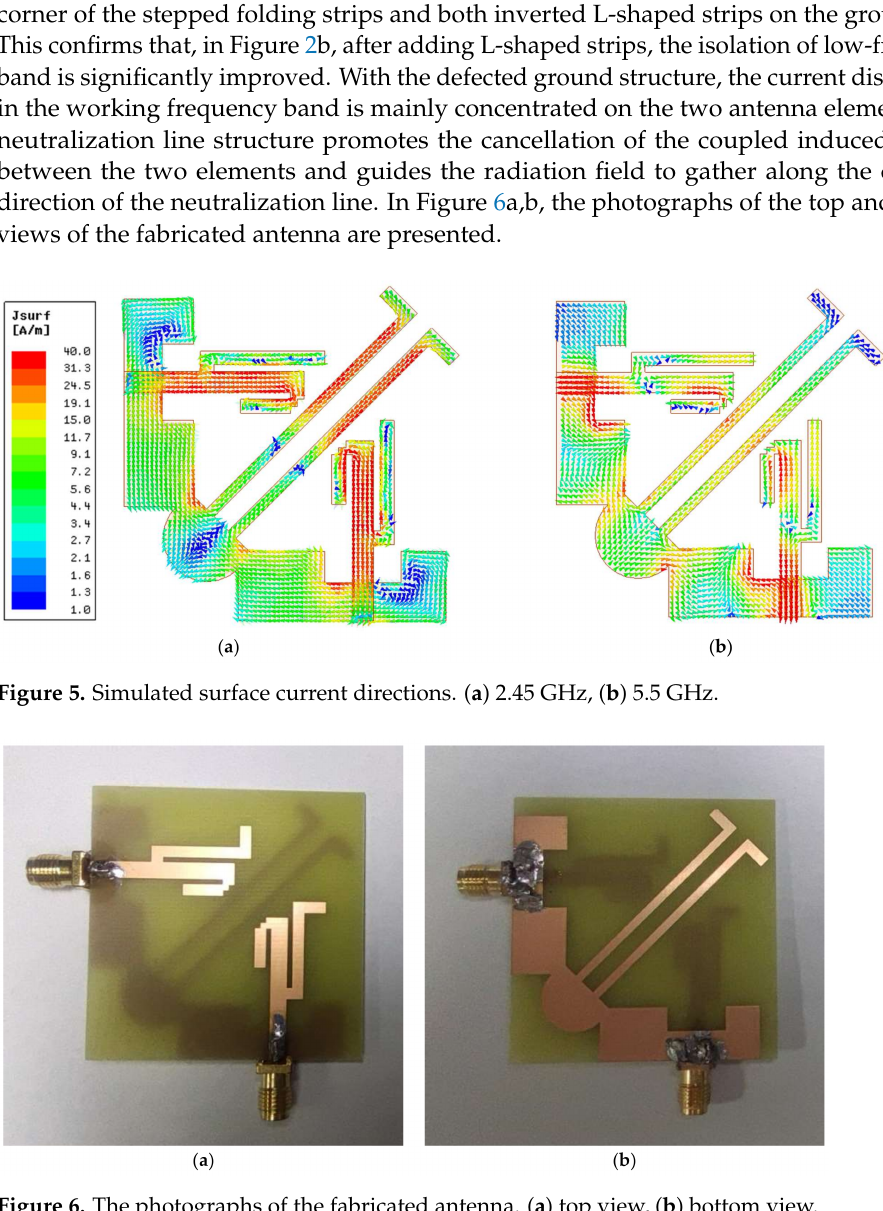
Figure 6. The photographs of the fabricated antenna. ( a ) top view, ( b ) bottom